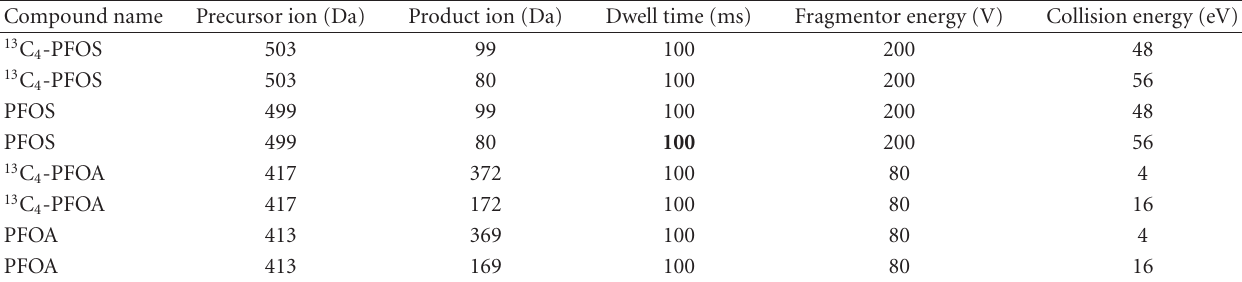
Table 1: Ionization and fragmentation conditions for PFOS and PFOA, using an ESI source in negative ion